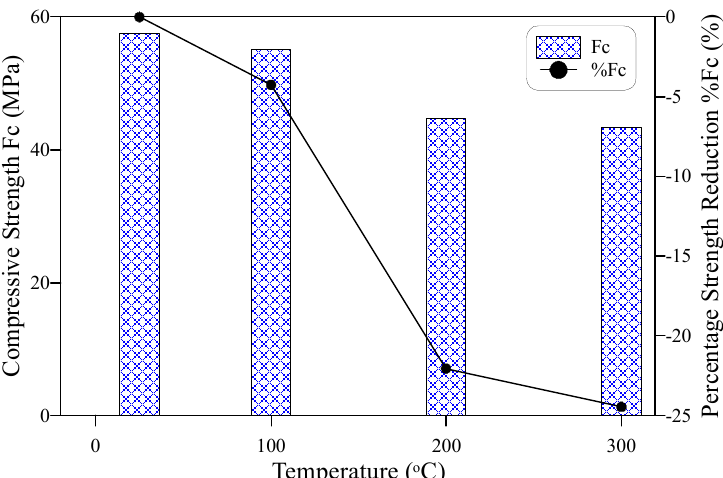
Figure 4. Compressive strength-temperature behavior.